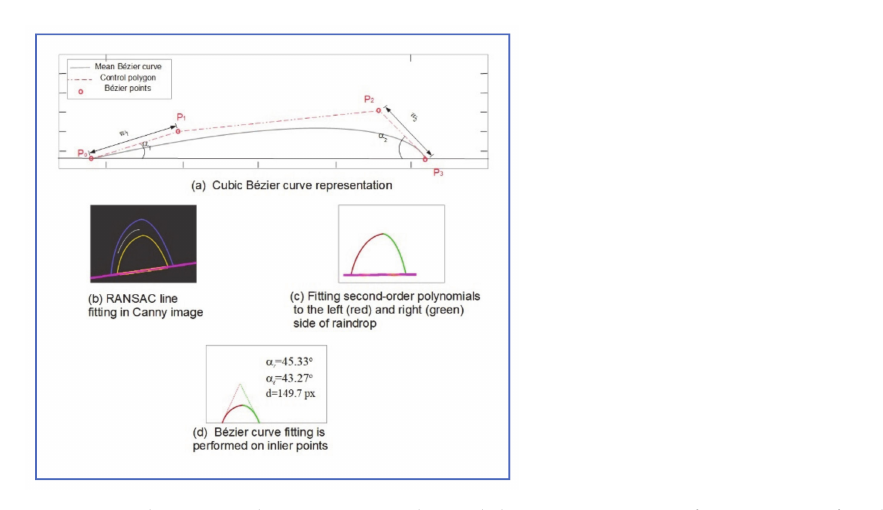
Figure 9. Relating raindrop contact angles and diameter to points of B é zier curve fitted to it